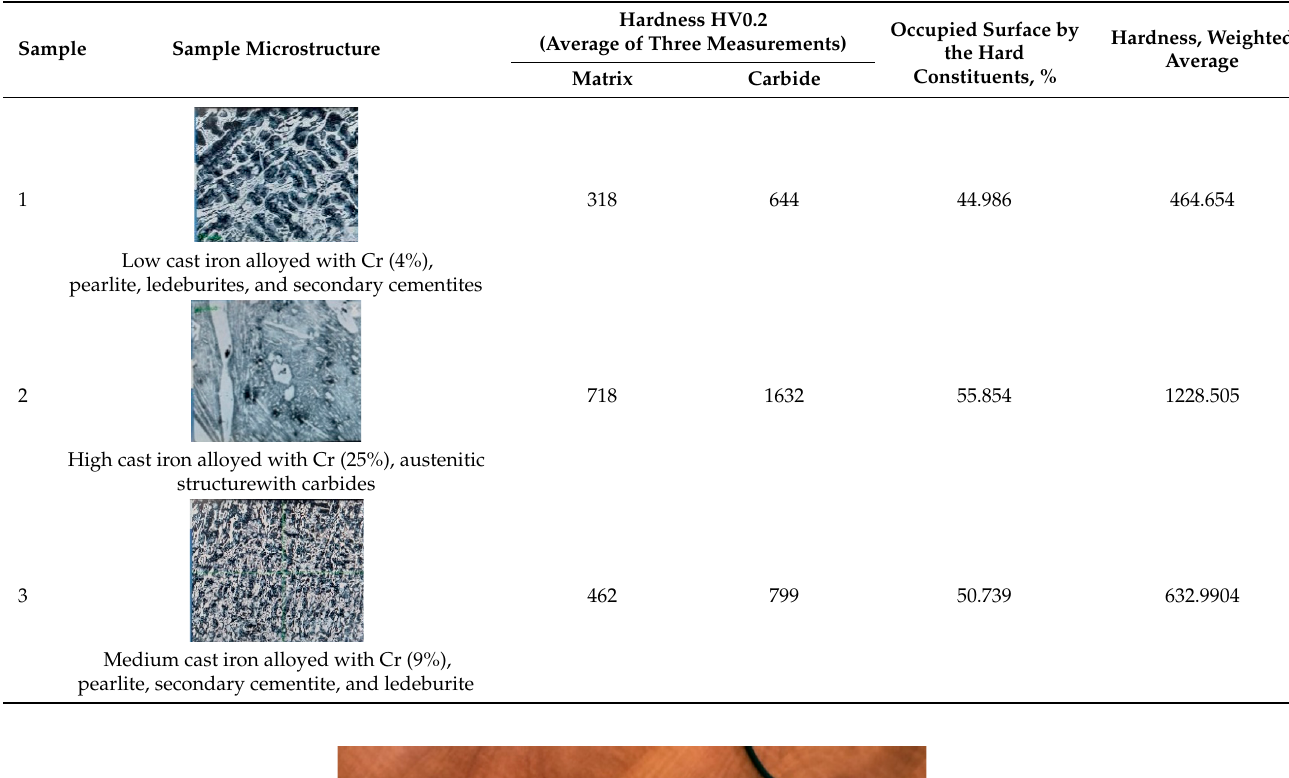
Table 2. The microstructures and hardness values for the cast iron samples.